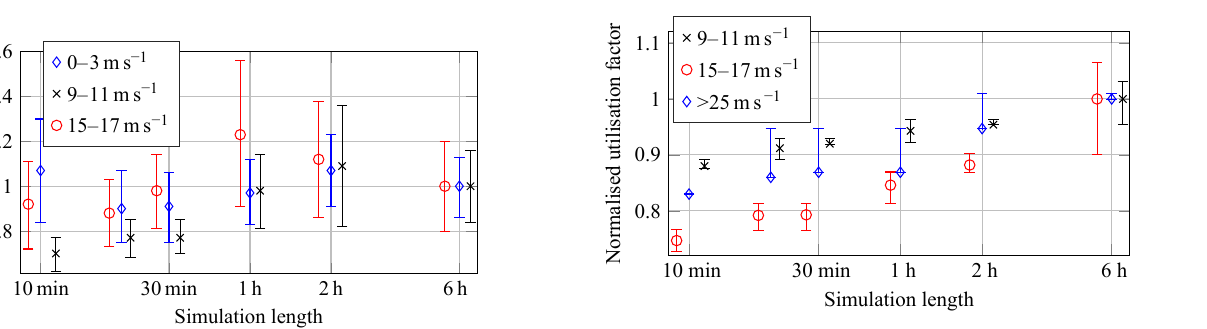
Figure 10. Normalised mean fatigue damage (500 simulations) for increasing simulation lengths and different wind speeds.